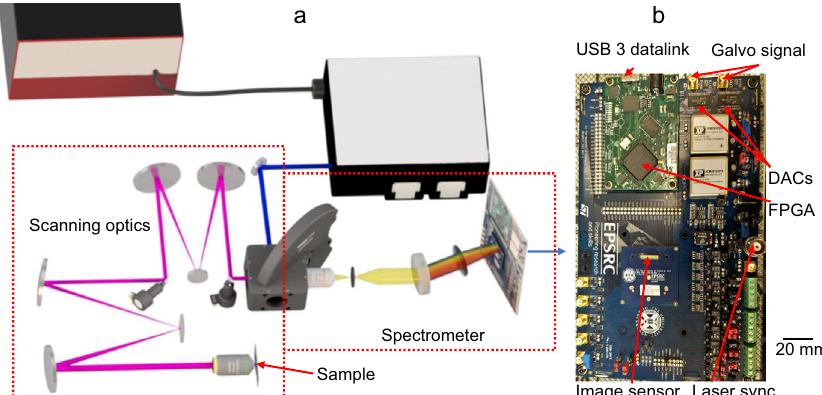
Fig. 1 Optical imaging system layout. a Optical path of the system (not to scale). The incoming supercontinuum laser is fi ltered via an acousto-optic fi lter allowing up to 8 colors to be selected before being directed to a fi lter wheel where a dichroic re fl ects the beam into the scanning optics. Two galvo mirrors scan in X and Y to form a stationary point onto the back plane of the primary objective. Returning fl uorescence is de-scanned and passed to the spectrometer via a pinhole where it is dispersed onto the image sensor. Further details of the optical setup can be found in the methods section. b The imaging line sensor mounted on a printed circuit board (PCB) along with the fi eld programmable gate array (FPGA) and two digital-to-analog converters (DACs) which are used together to control the position of the galvo mirrors. The scale bar relates to the PCB, not to the rest of the optical system shown in a